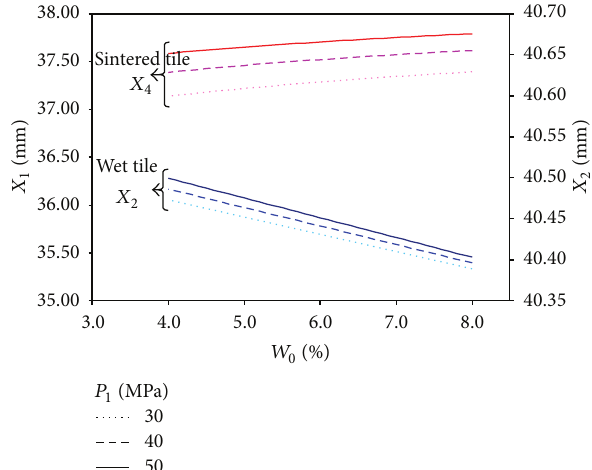
Figure 12: Influence of spray-dried powder moisture ( 𝑊 0 ) and maximum pressing pressure ( 𝑃 1 ) on wet and sintered tile sizes ( 𝑋 2 and 𝑋 4